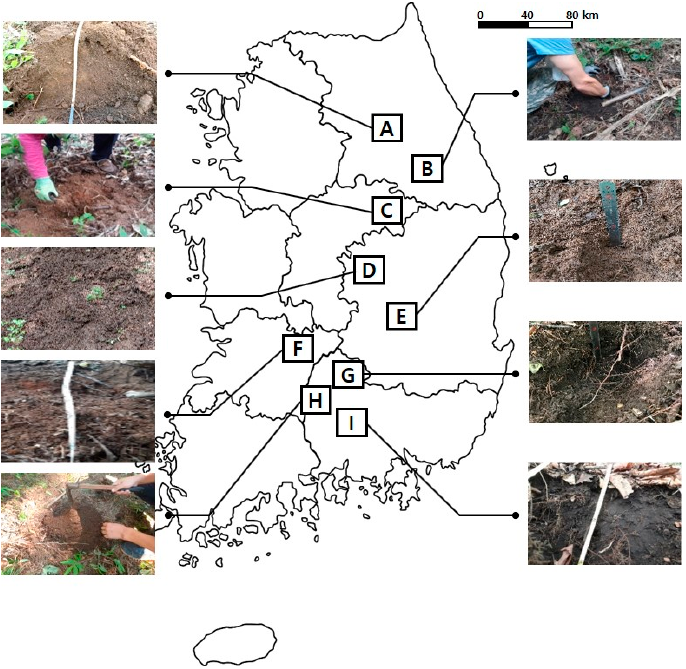
Figure 1. Study area and soil sampling sites of 13-year-old Wild-simulated ginseng (WSG). A-I are a wild-simulated ginseng(WSG) cultivation sites in South Korea.